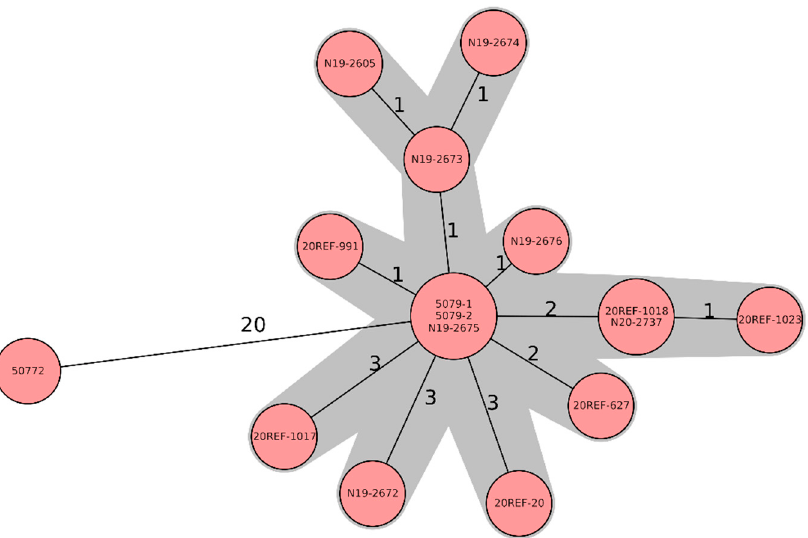
Figure 1. Minimum-spanning tree based on cgMLST allelic profiles of 16 Salmonella Jerusalem isolates, six feed isolates (soya), and ten chicken isolates. Each circle represents an allelic profile based on a sequence analysis of 3,002 cgMLST target genes. The numbers on the connecting lines represent the number of allelic differences between two strains. Each circle contains the strain ID(s), as listed in Table 1.